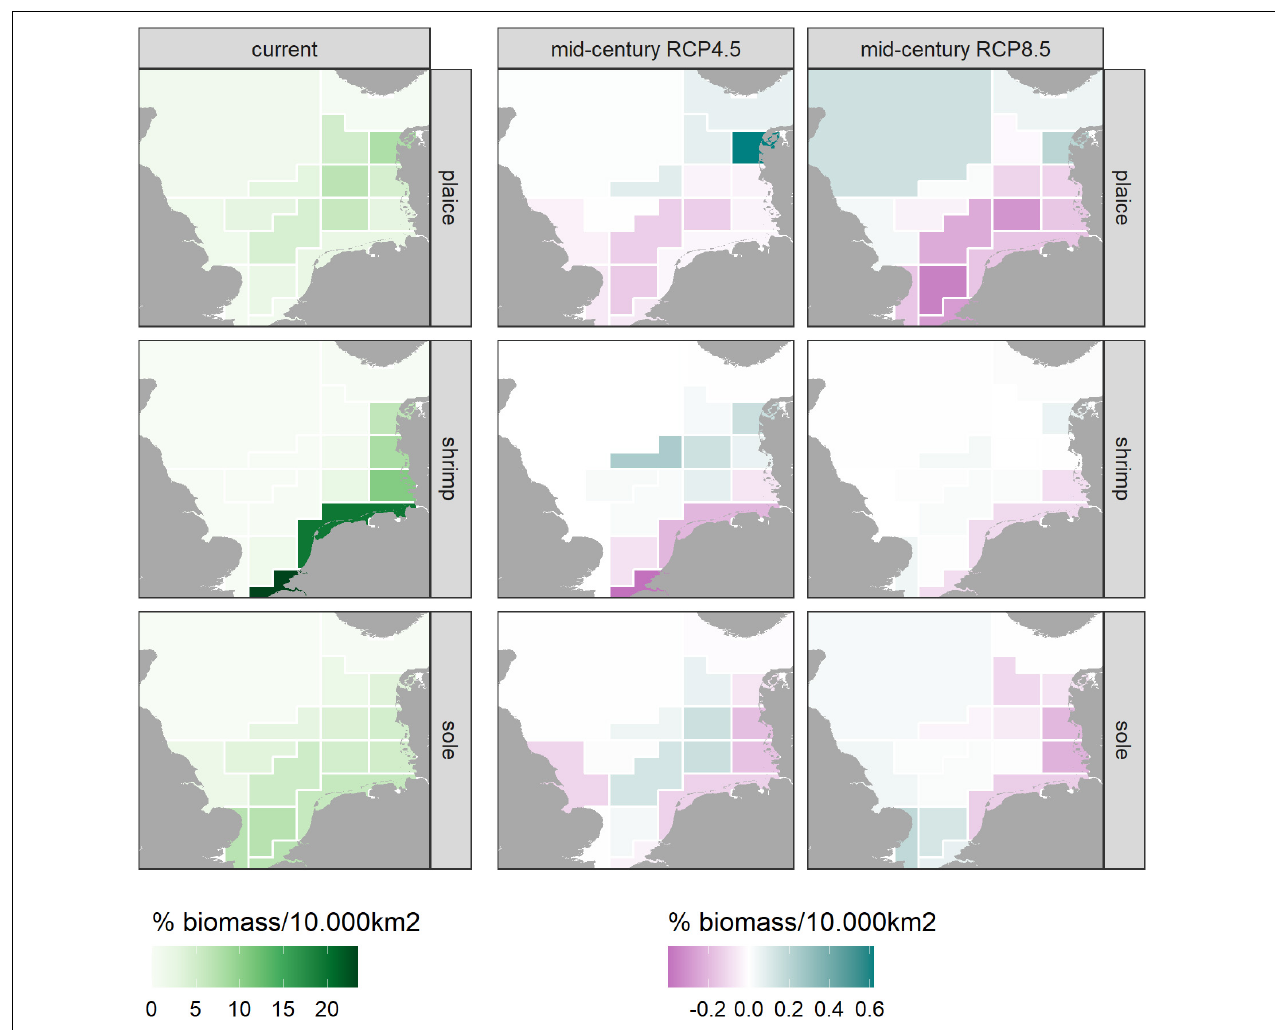
FIGURE 5 | Current (2016) and projected (2050) change in distribution of plaice, sole and shrimp (green gradient) used in the SIMFISH model. Mid-century projections were made for two RCPs (4.5 and